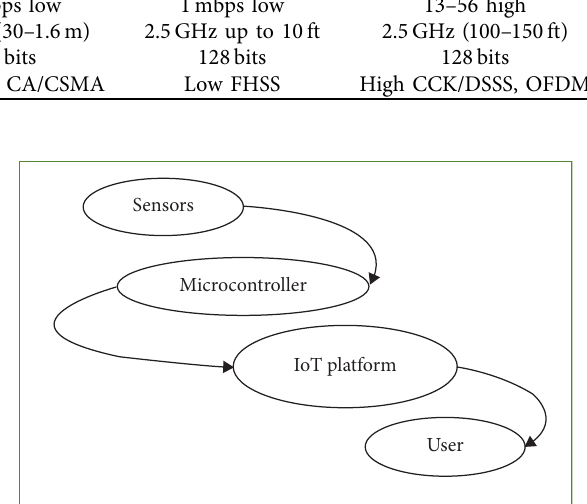
Figure 4: Block diagram of the agriculture monitoring system.